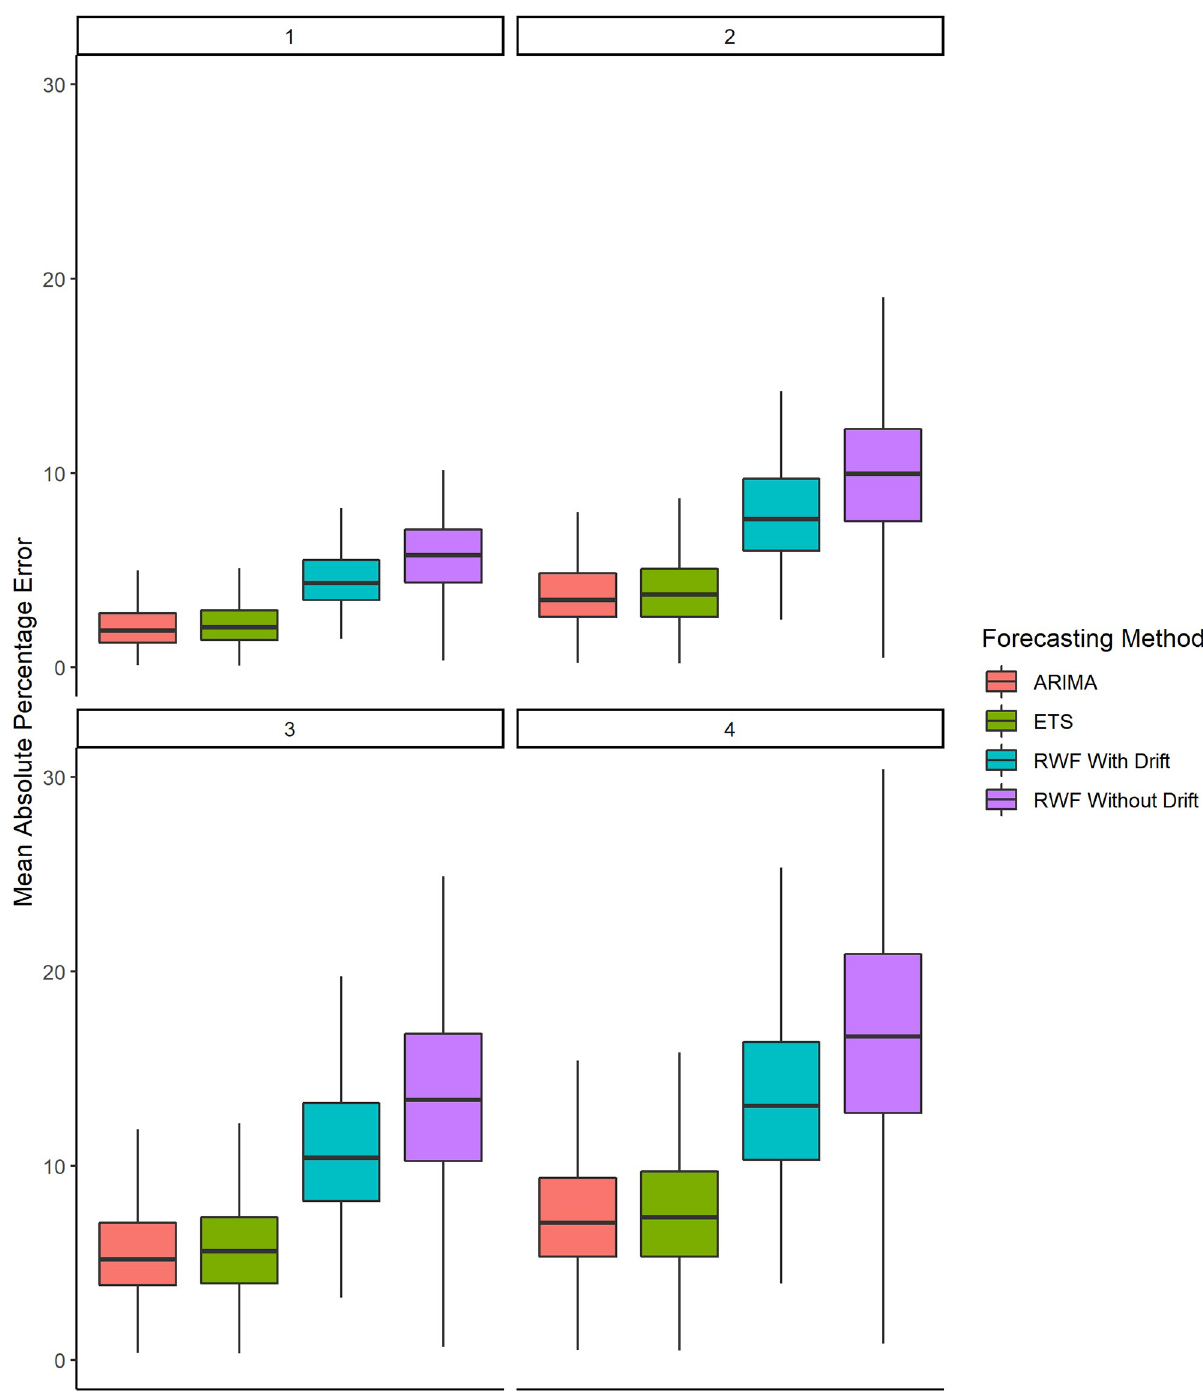
Fig 3. Boxplots of the MAPE results (without the outliers) for 187 countries and at the aggregated level of the world.